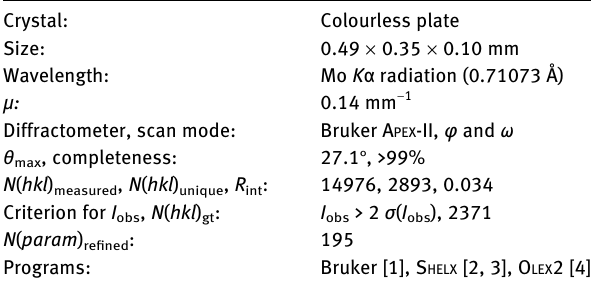
Table 1 contains crystallographic data and Table 2 contains the list of the atoms including atomic coordinates and displacement parameters.